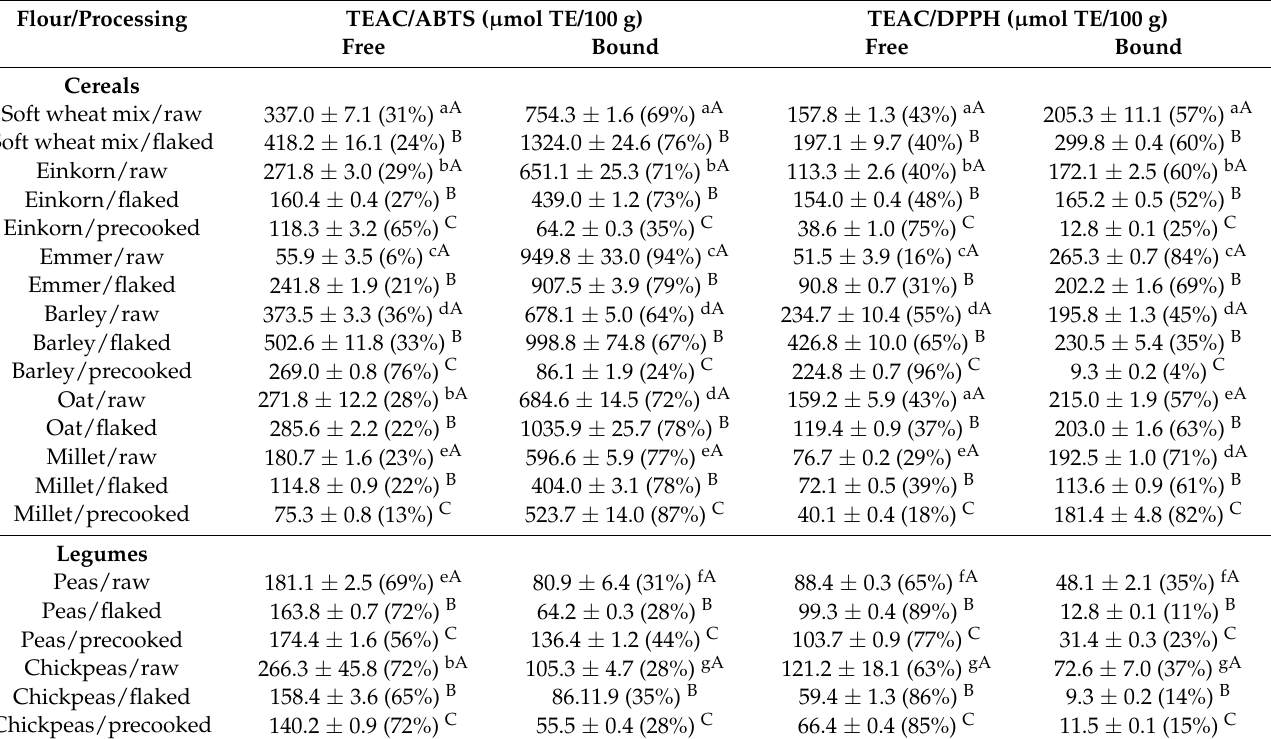
Table 4. Free and bound Trolox equivalent antioxidant capacity (TEAC) determined by the ABTS and DPPH assays in the hydrophilic extracts, reported as mean ± SD ( n = 27). The values in brackets represent the contribution of free and bound fractions to the total antioxidant capacity that can be calculated as the sum of the two